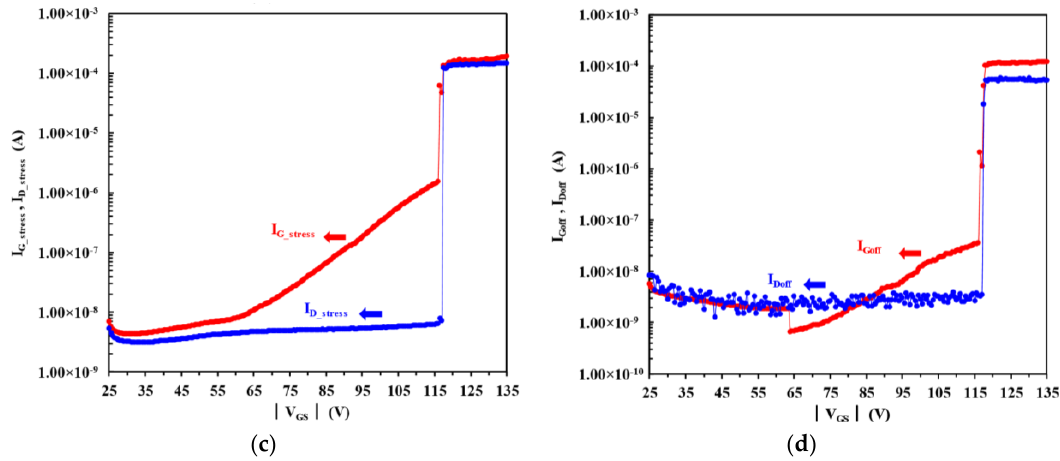
Figure 4. ( a ) Sketch of MIS-HEMT under step-stress of the gate reverse bias at V DS = 0 V from |V GS | = 25 to 135 V in 0.5 V. A high-field appears at the gate edges on both the drain and source sides; ( b ) Electrical figures of merit as a function of |V GS |: percent increase in dynamic R on (drain current degradation) and percent positive shift in V th (left scale). The inset in ( b ) depicts that a large positive V th shift is induced during stress, changing it from −18.95 to −12.45 V; ( c ) 2-terminals I-V characteristics acquired during stress. A sudden increase of gate current (I G_stress ) is measured at |V GS | = 65 V; ( d ) 2-terminals leakage currents acquired after stress.